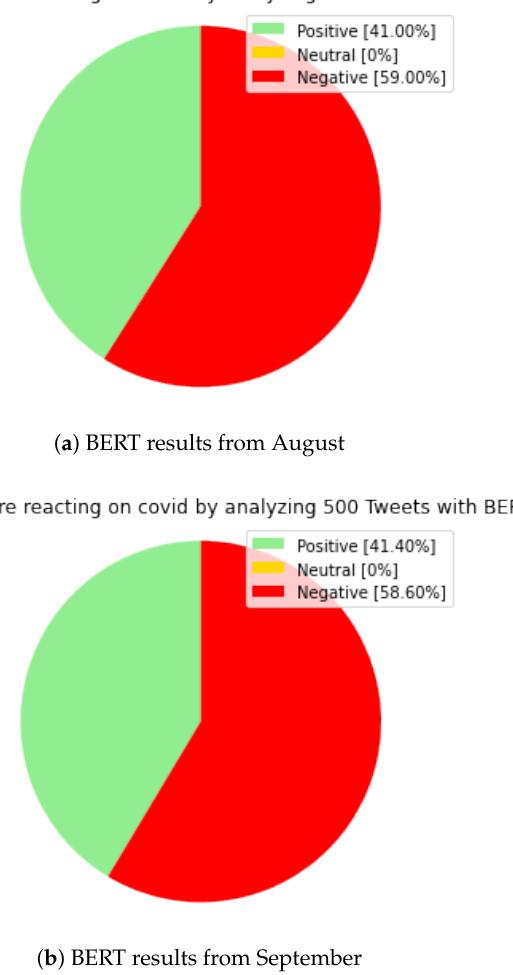
Figure 5. Analysis of sample of 500 tweets by BERT, using ‘COVID’ keyword. The time periods stands between 29 August 2021 and 31 August 2021, and 2 September 2021 and 4 September